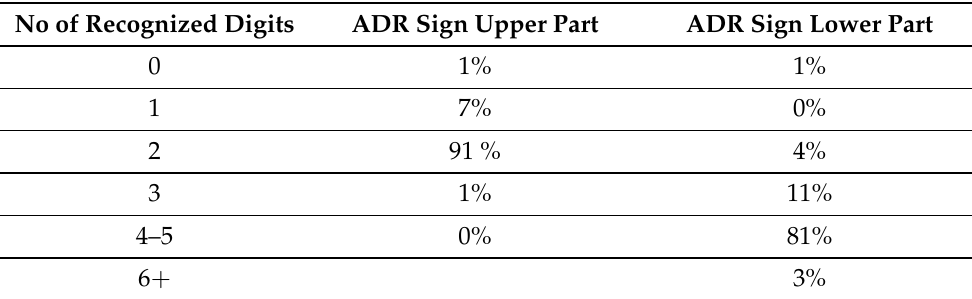
Table 4. Results of the software’s optical character recognition capabilities on a dataset of 100 pho- tographs of ADR